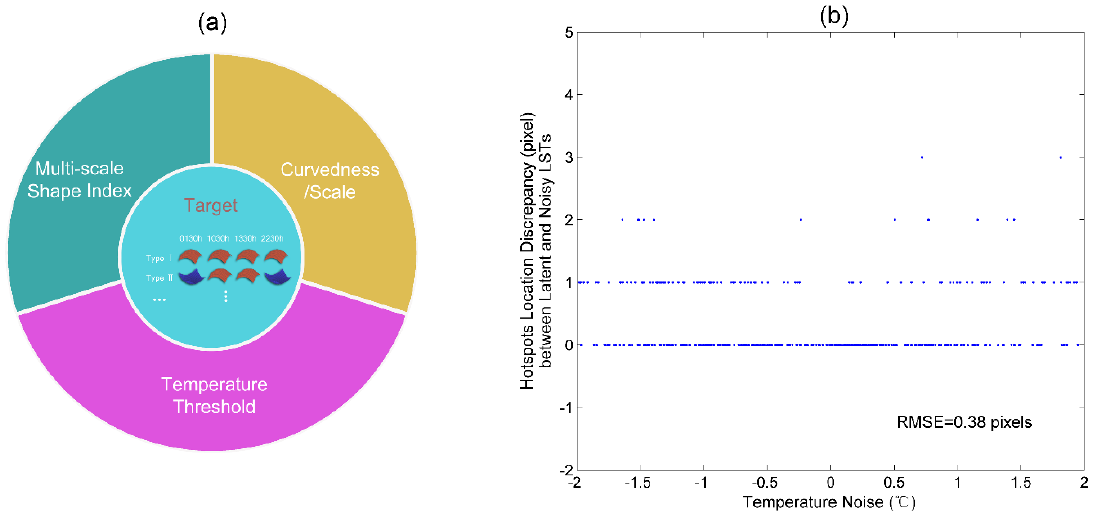
Figure 8. ( a ) The triplet criteria for analyzing the dynamics of the LST; ( b ) The robustness of locating pixels with the triplet criteria.